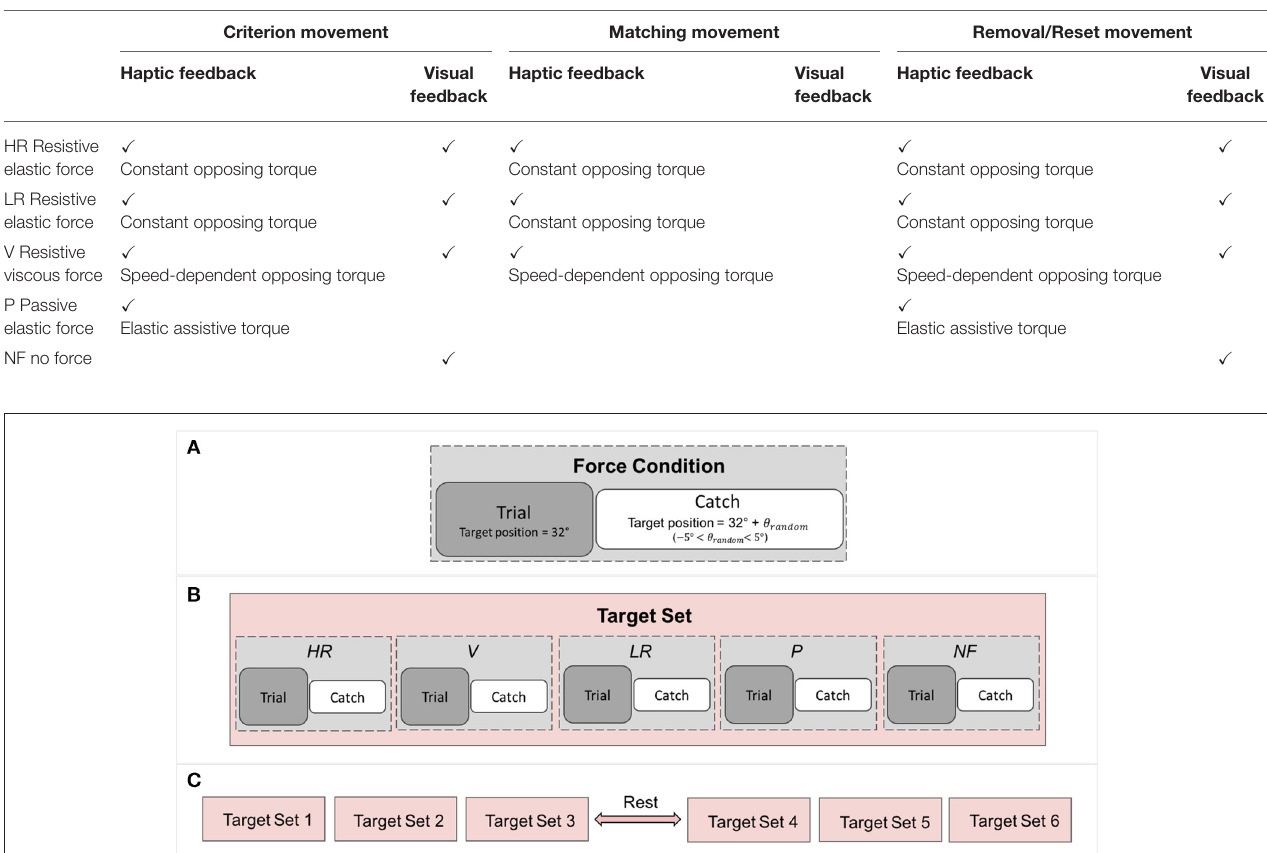
TABLE 1 | Feedback (haptic and visual) during reaching and matching movement in the five force conditions.